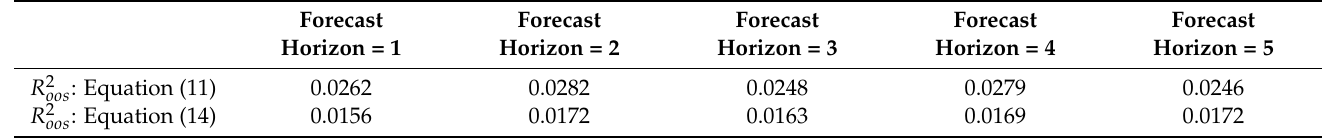
Table 9. Comparison of Equations (11) and (14) in out-of-sample